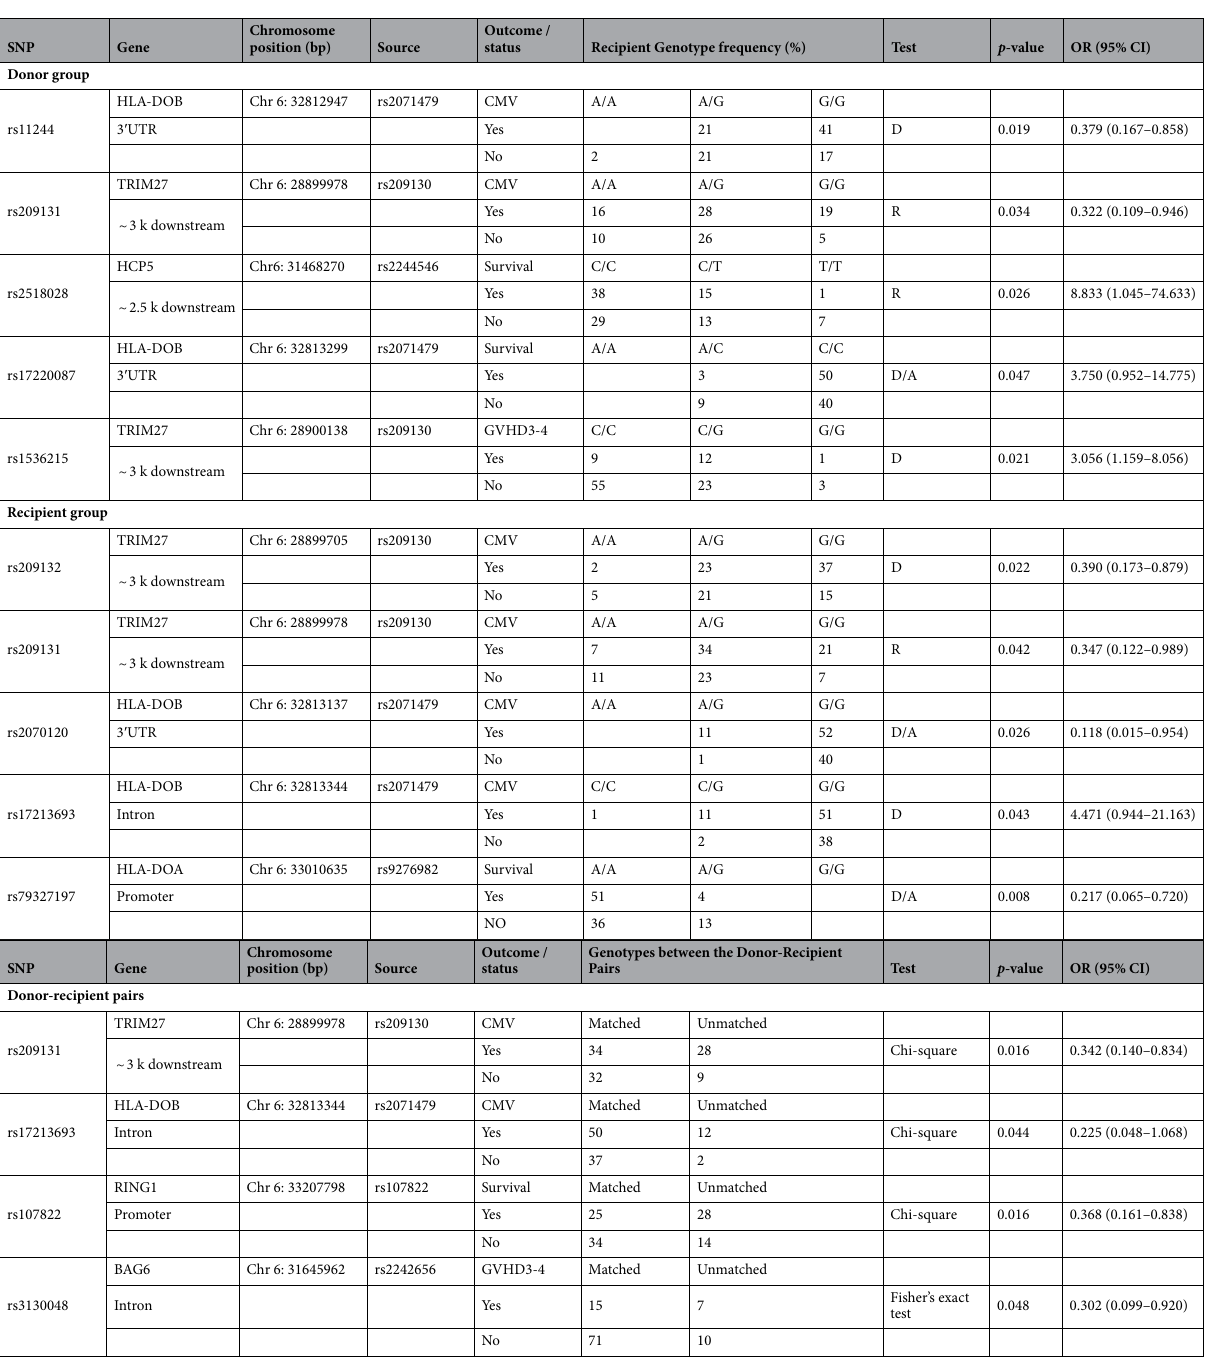
Table 3. The SNPs significant association with three adverse reactions in AML group. D: dominant model (AA vs. Aa + aa); R: recessive model (AA + Aa vs. aa); A: additive model (AA vs. Aa vs. aa), in which ‘A’ was defined as a higher frequency allele and the lower was ‘a’. Fisher’s exact test was used when more than 20% of cells had an expected count of less than 5 for the Chi-square test. The unmatched was used as a standard for odds ratio here. In other words, the chance for getting CMV infection, severe GVHD and survival in the matched genotype in donor-recipient pairs compared to those